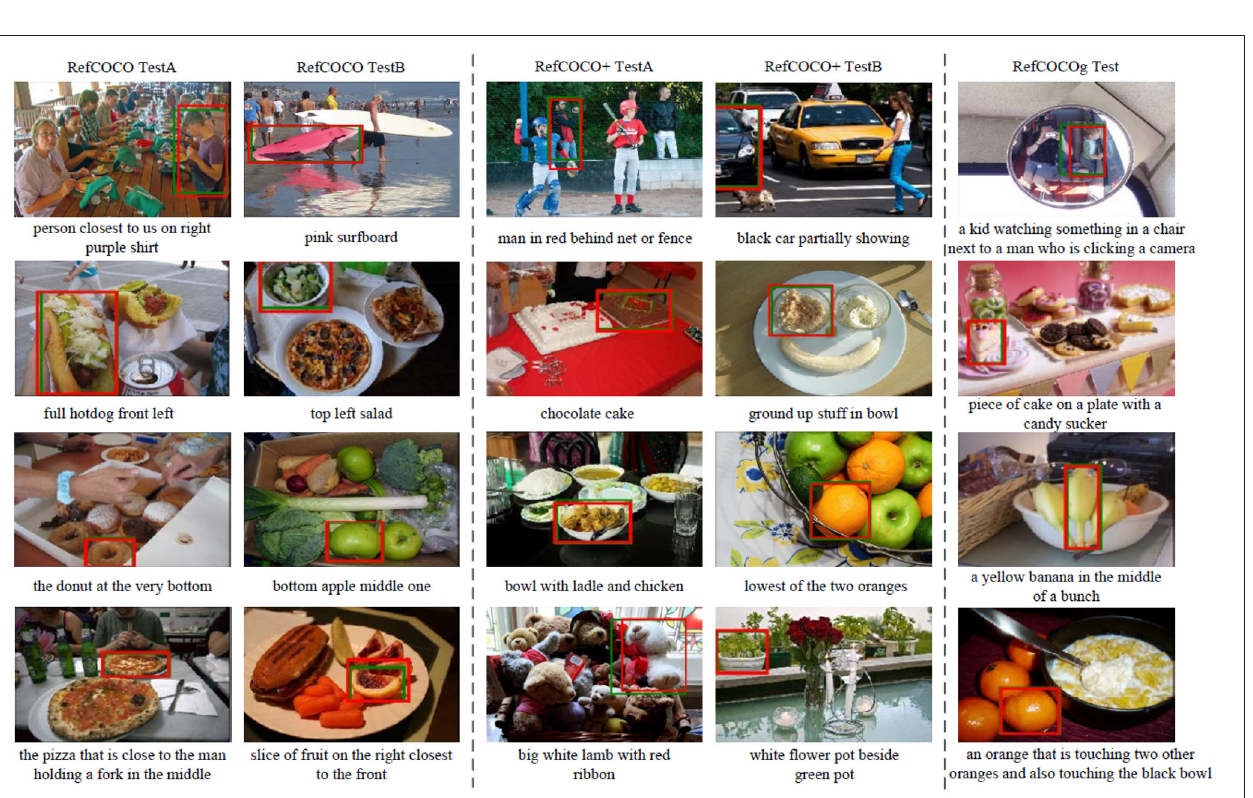
FIGURE 3 | Example results of referring expression comprehension on test sets of RefCOCO, RefCOCO + , and RefCOCOg. Referring expressions are listed under the related images. In each image, the red box represents the correct grounding, and the green bounding box denotes the ground